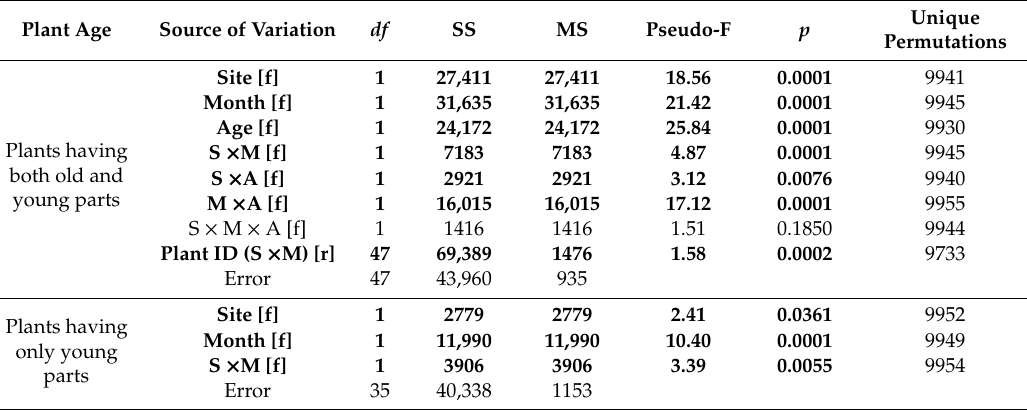
Table 3. E ff ects of plant part age (young or old), month (July or September), and location (sites K or V) on multivariate community structure of epibiosis on Phycodrys rubens : type III sum of squares PERMANOVA for 9999 permutations on fourth root transformed covers of sessile epibionts, Bray-Curtis similarity, frames pooled. Significant terms highlighted in bold. [f]—fixed e ff ect, [r]—random e ff ect. Plant Age